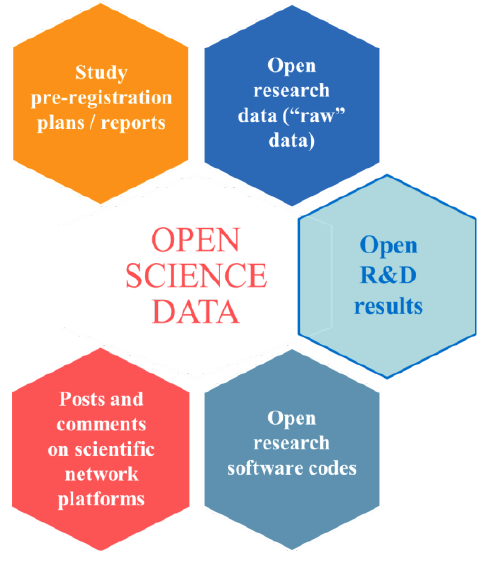
Fig. 5. Content-based categories of OS